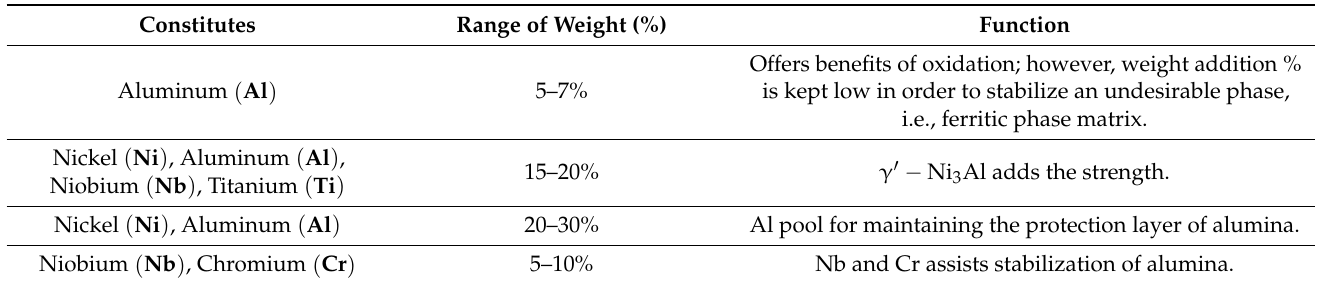
Table 3. Combinations of Fe-based